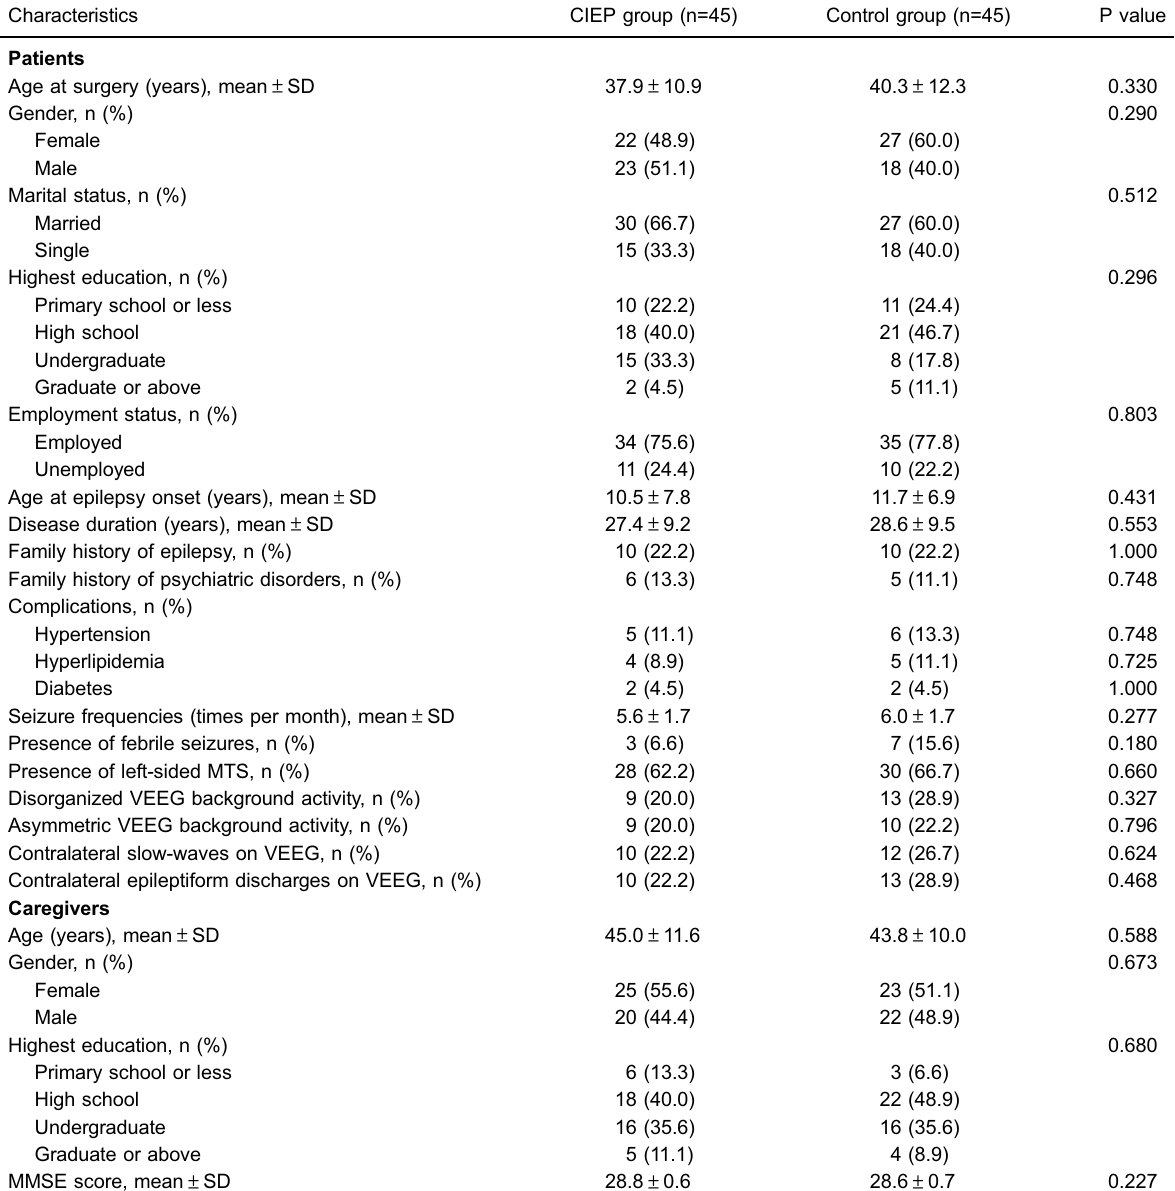
Table 2. Characteristics of patients with drug-resistant refractory temporal lobe epilepsy and mesial temporal sclerosis (TLE-MTS) and their caregivers.